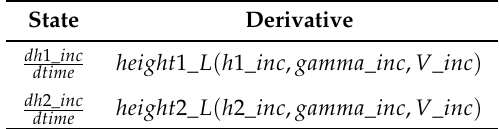
Table 5. Differential equations of the linearized system (linear MIMO).